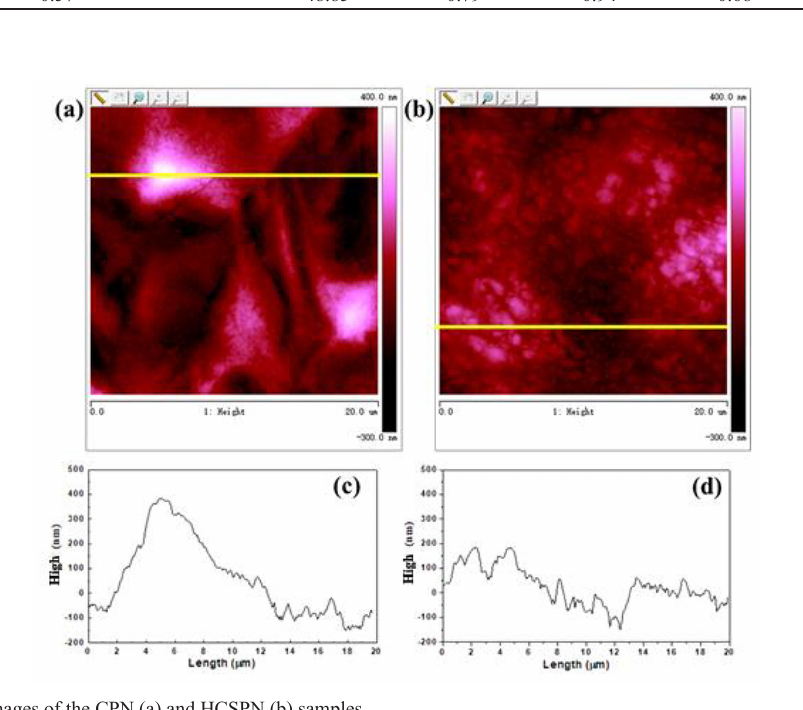
Figure 6. AFM images of the CPN (a) and HCSPN (b) samples.